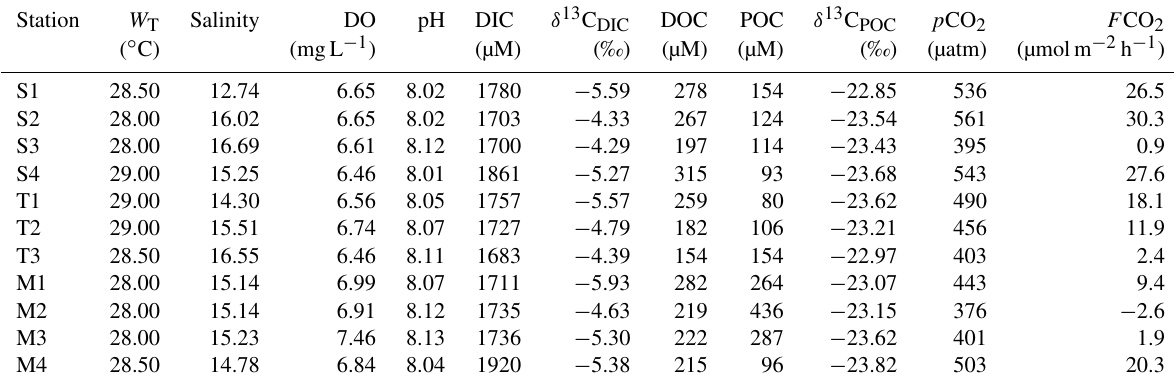
Table 2. Physicochemical parameters, inorganic and organic C-related parameters and CO 2 exchange flux across the water–atmosphere interface at the estuaries of the Sundarbans. Here, W T is water temperature, DO is dissolved oxygen. Station